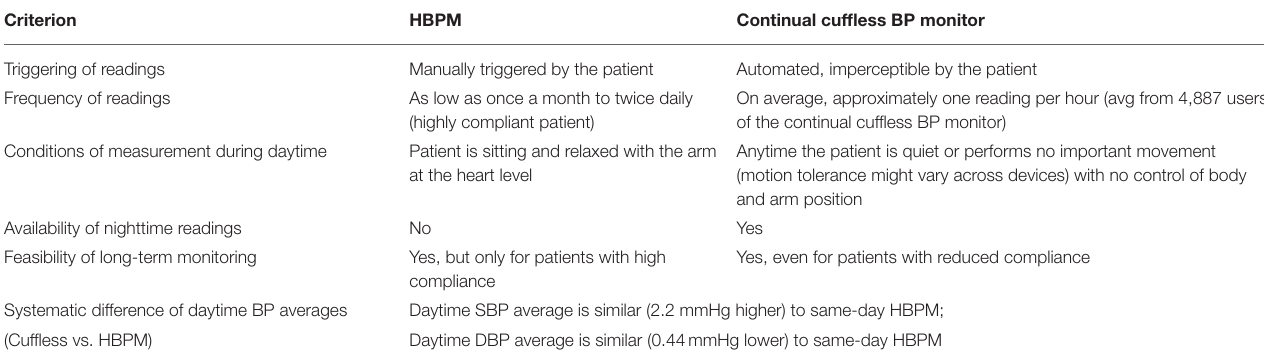
TABLE 3 | Guidance for the interpretation of daytime averages obtained from a continual cuffless BP monitor when compared to daytime averages obtained from HBPM. Criterion